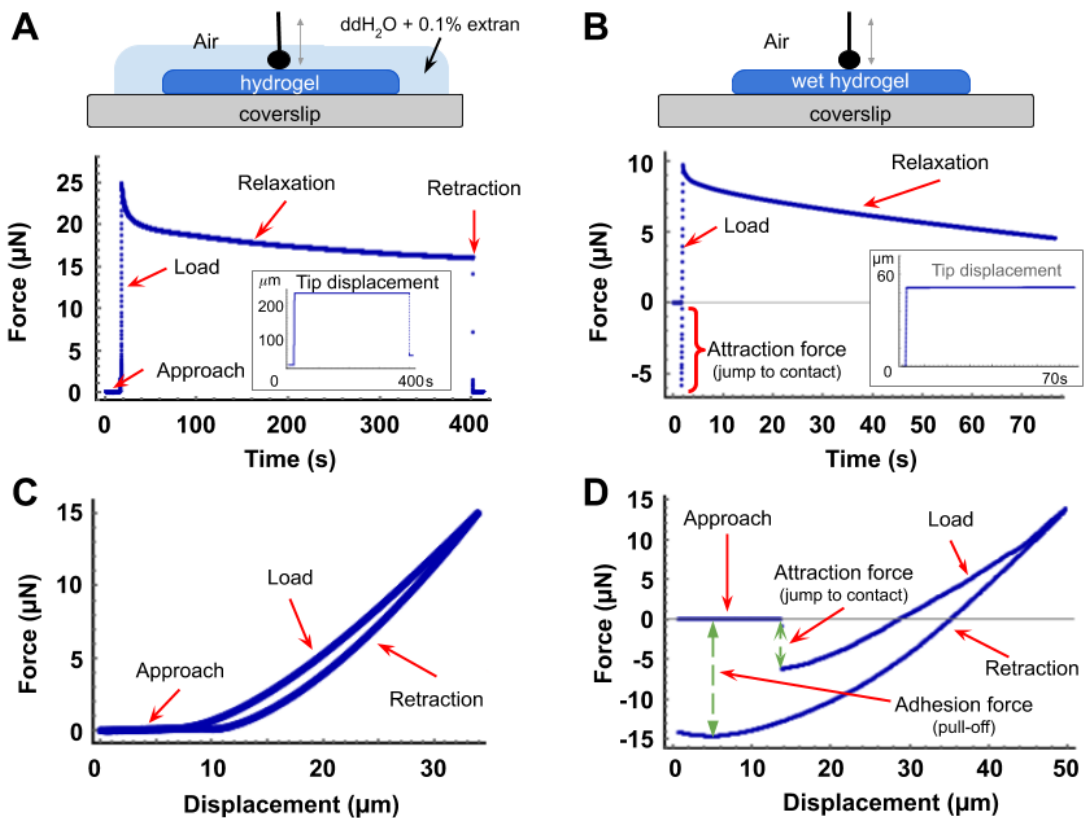
Figure 2. Force curves of microindentation-relaxation assays. Graphs of A ) and B ) are force-time curves representative of the relaxation of a soft polyacrylamide hydrogel using a spherical tip with a 25 µm radius. Red arrows signal the different sections of the curve and the embedded insets show the constant position of the tip, equivalent to a constant indentation of the sample. A ): relaxation curve obtained from a sample measured when submerged in a detergent solution of ddH 2 O and 0.1% Extran. B): relaxation curve from a measurement in air of a similar hydrogel sample soaked with water ( ddH 2 O ). Graphs of C ) and D ) are force-displacement curves, representative of the microindentation-retraction cycle of a soft hydrogel using the same tip. Red arrows signal the different sections of the curve and the magnitude of the attraction between the tip and the sample. Hysteresis can be observed between load and retraction in both cases. C) and D) represent the same measurement conditions as in panels A) and B), respectively.